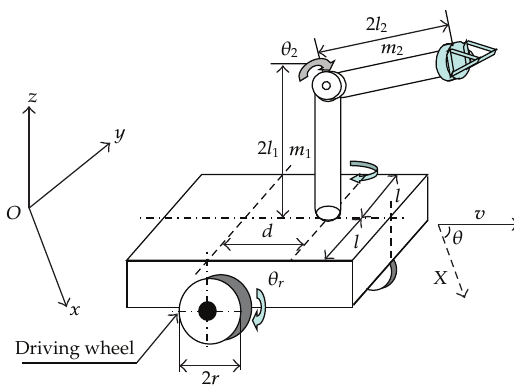
Figure 1: The 2-DOF mobile